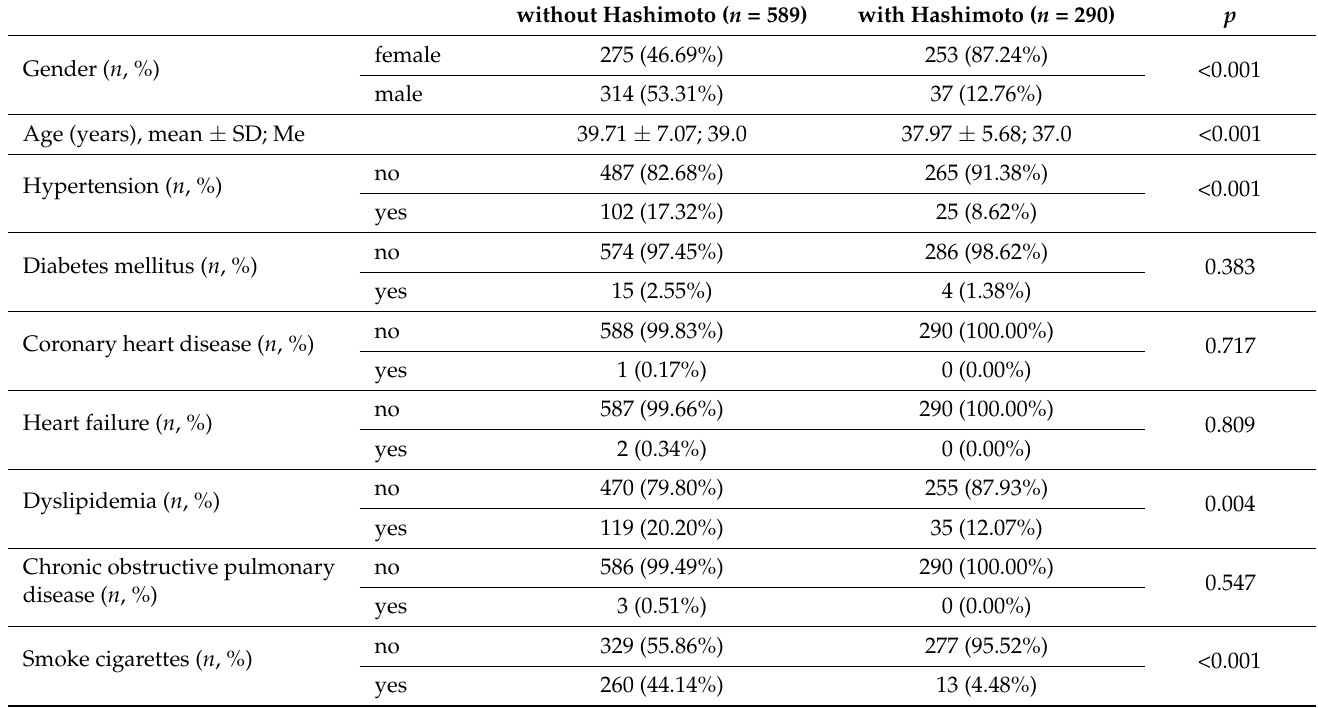
Table 3. Evaluation of selected parameters depending on the occurrence of Hashimoto’s disease.